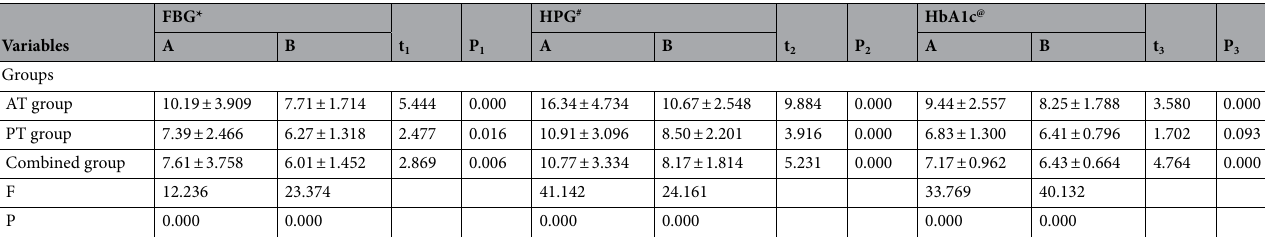
Table 1. Comparisons of blood glucose and HbA1c levels among the three groups before and after treatment. A: baseline; B: after the treatment. P: Comparison among the three groups before and after treatment. P1- P3: Self-control comparisons in each group. *: Fasting blood-glucose. # : 2 h postprandial blood glucose. @: Glycosylated